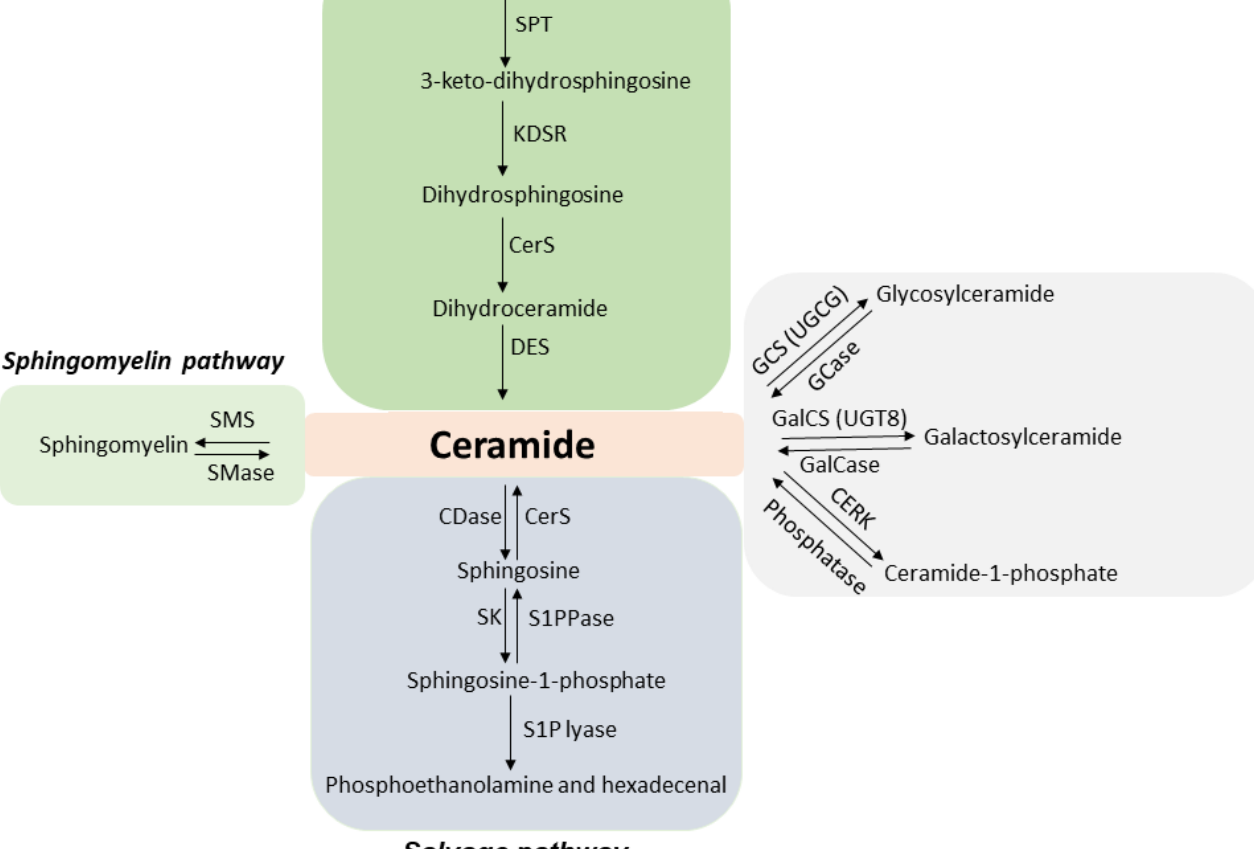
Figure 1. Diagram depicting ceramide synthesis and metabolism pathways. Ceramide generation takes place by three different pathways. The first one occurs at the plasma membrane in the presence of enzyme acid sphingomyelinase (ASMase). Hydrolysis of sphingomyelin in the presence of ASMase results in ceramide release. Secondly, the de novo pathway regulates ceramide generation by the condensation of palmitate and serine. 3-keto-dihydrosphingosine formed through this process is catabolized further to dihydroceramide. Ceramide generated in the endoplasmic reticulum is transported to the Golgi apparatus. This process is mediated by vesicle trafficking or by the involvement of ceramide transfer protein (CERT). Lastly, ceramide is generated by sphingolipids and glycosphingolipids degradation through the salvage pathway taking place in the late endosomes and the lysosomes. Ceramide can also be converted to complex sphingolipids. Abbreviations: CDase —